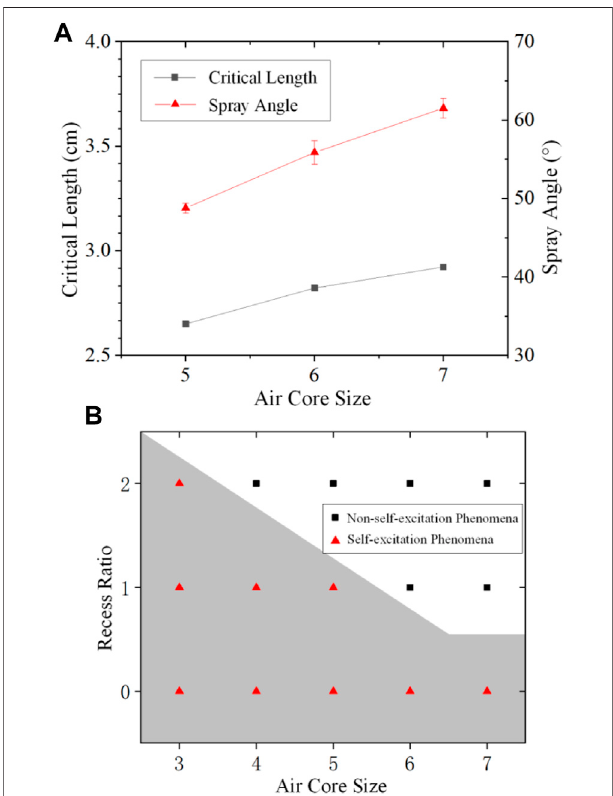
FIGURE 13 | (A) The breakup features of spray under various air core sizes. (B) Parameter boundaries of self-excited oscillatory phenomena.